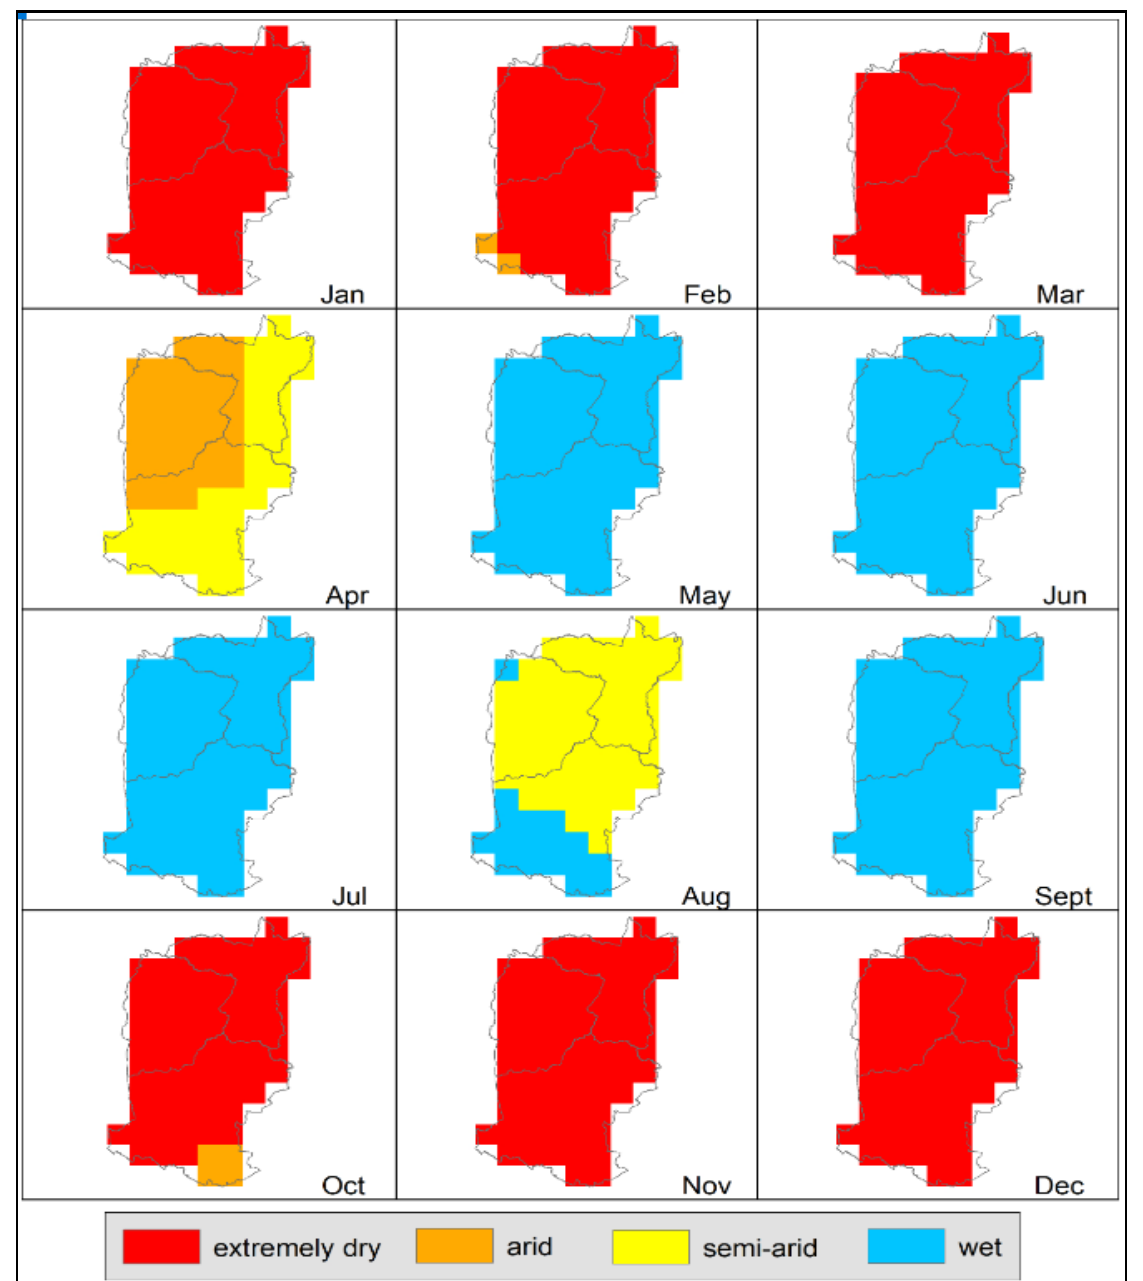
Figure 5. Thornthwaite aridity index map for 2004.